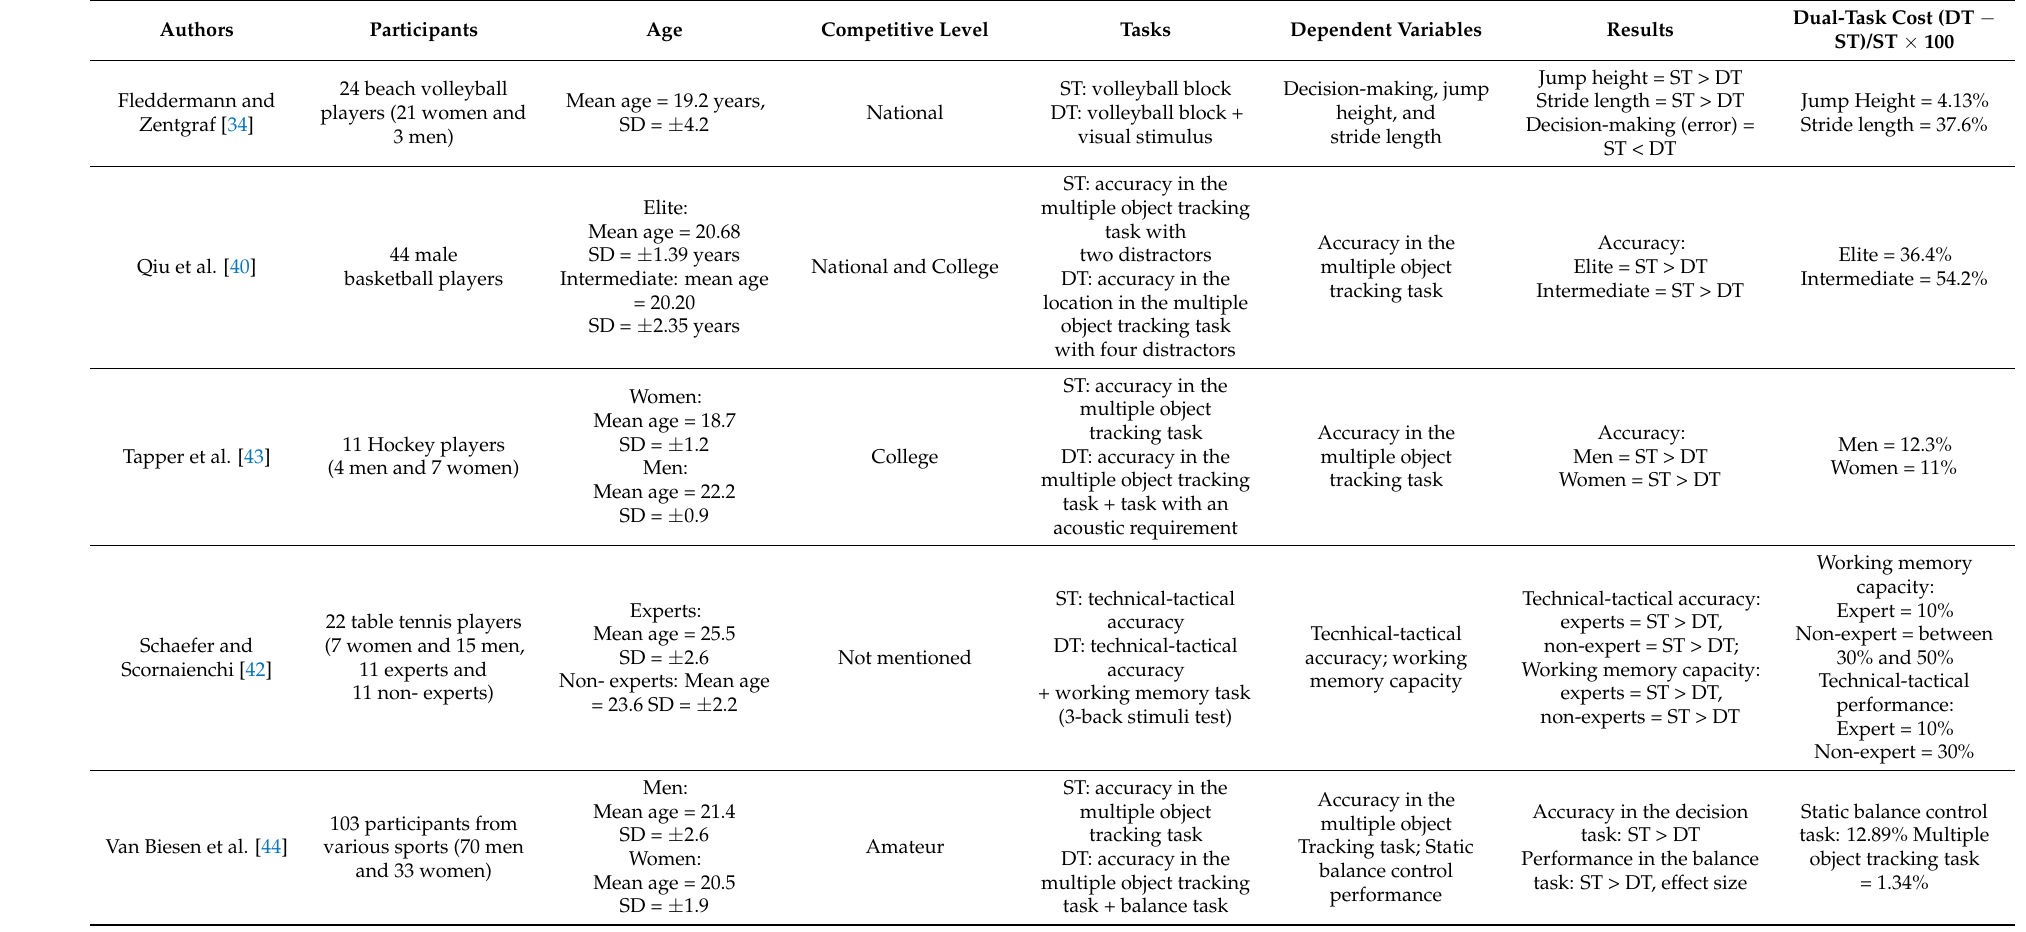
Table 2. Selected studies on the acute effect of